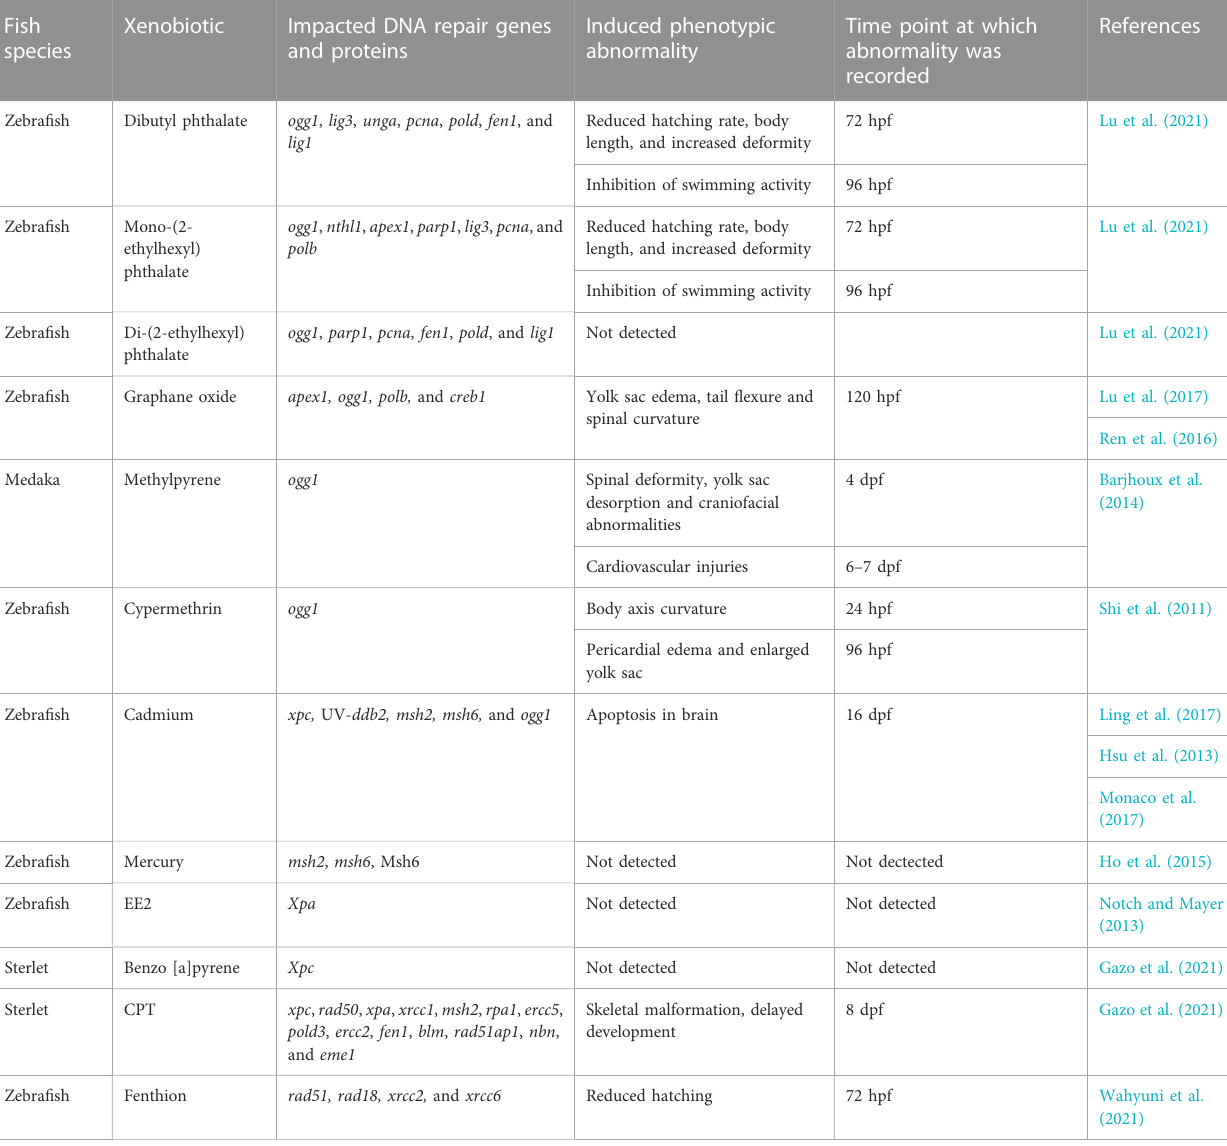
TABLE 2 Effect of xenobiotics on expression of DNA repair genes and proteins during fi sh embryogenesis and corresponding abnormality induced. Fish Xenobiotic Impacted DNA repair genes Induced phenotypic species and proteins